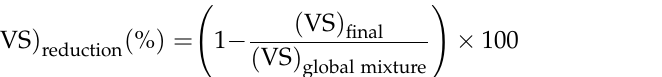
Figure 8. Daily net bio-methane production of the two bottles.